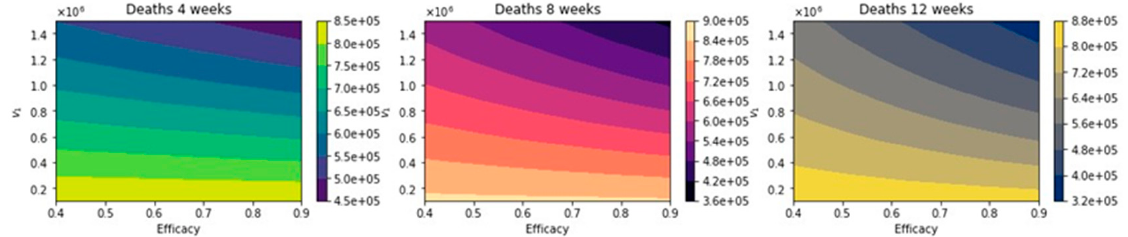
Figure 8. Total number of deaths for a variety of vaccine efficacies after the first dose and different vaccination rates per day. The basic reproduction number R 0 > 1.